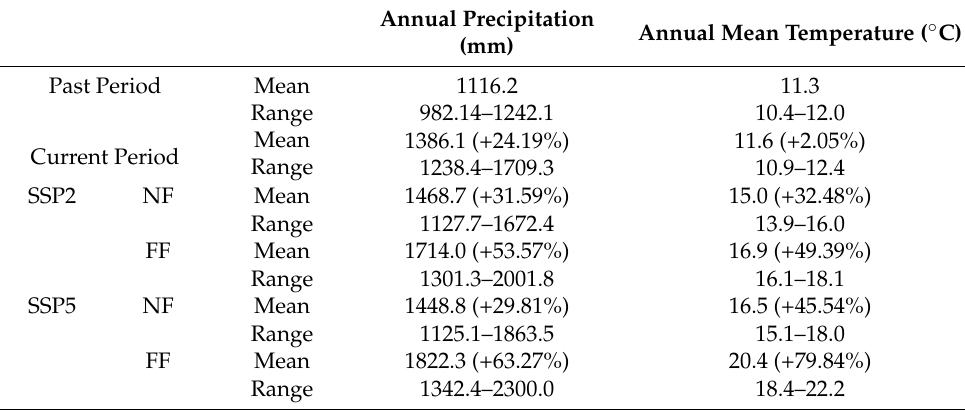
Table 7. Projected annual precipitation (mm) and annual mean temperature at the study area for the past period, current period, near future (NF), and far future (FF) under two shared socioeconomic pathways (SSPs)